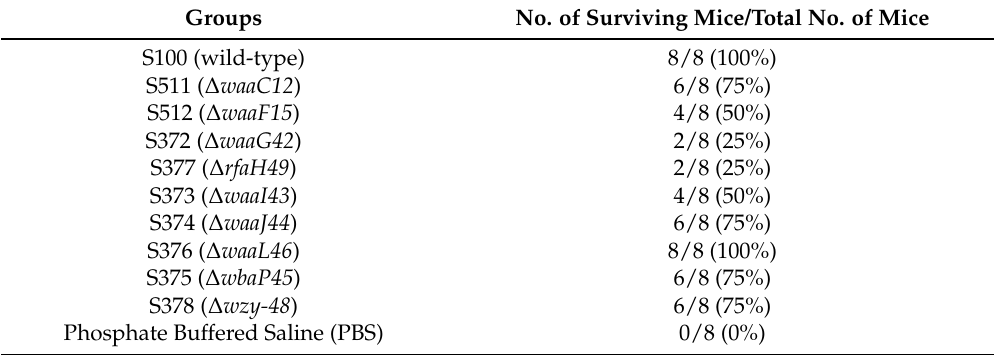
Table 1. Immunization with OMPs protected mice against oral challenge with S. Typhimurium strain